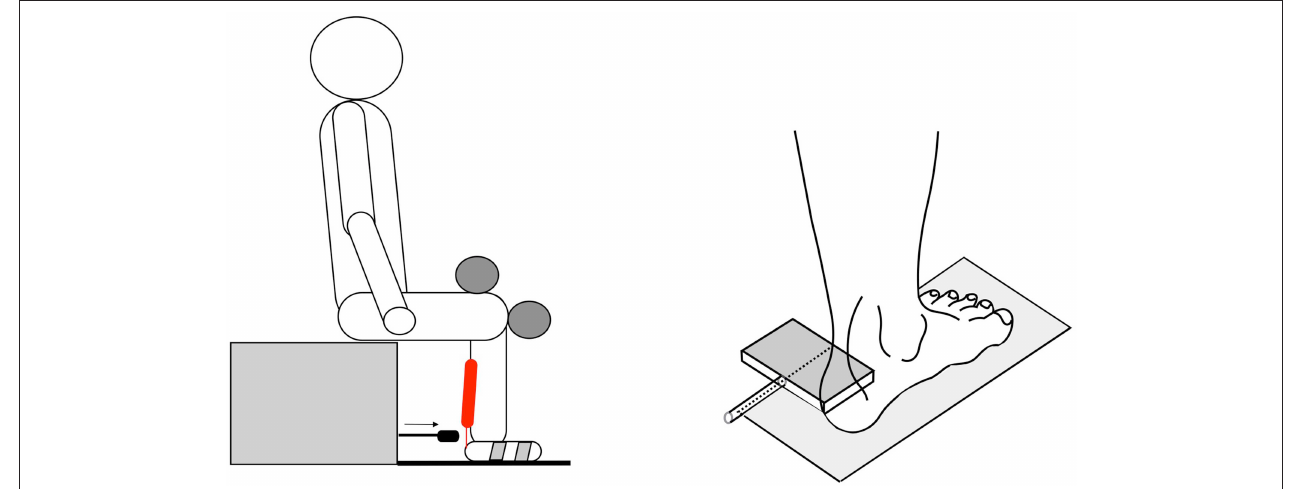
FIGURE 1 | The sketch shows the subject had a fixed sitting position. The subjects were seated comfortably upright, with a knee angle and a foot angle each of 90 ◦ . The left foot was fixed with two stirrups on a tempered (30 ◦ C) footplate. The upper leg was secured at the topside; the arm and head positions were kept constant during the whole experiment. The reflex-triggering hammer (right side) was equipped with a force sensor, in order to record the impact forces at the muscle-Achilles